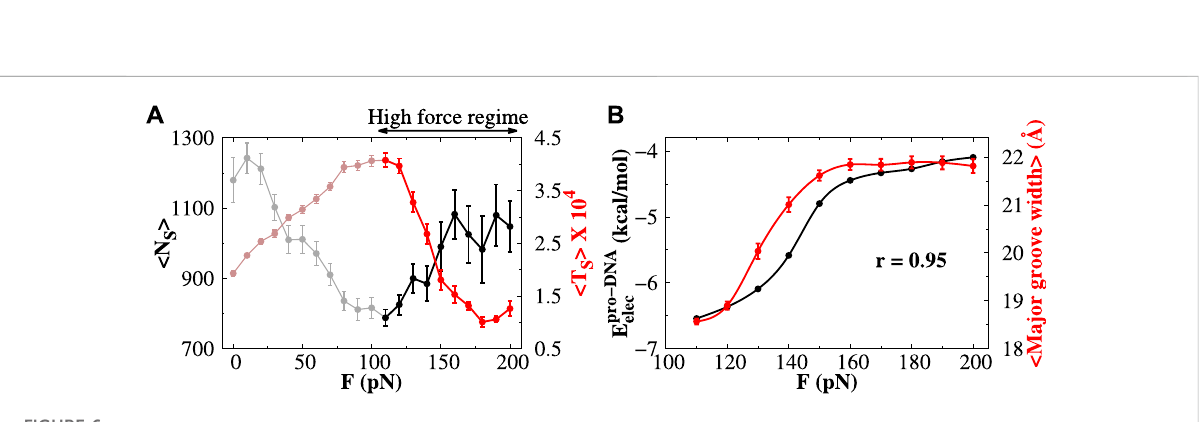
FIGURE 6 Protein diffusion under high stretching force. (A) Variations in the average number of sliding events ( < N S > ; black line) and the average time duration( < T S > ;redline)ofaslidingeventareplottedasafunctionofstretchingforce.Onlytheregimeunderhighstretchingforceishighlighted. (B) Correlations between the protein – DNA electrostatic energy and the average major groove width with the stretching force. The correlation coef fi cient between them is represented by r . The error bar for each symbol is de fi ned as the standard